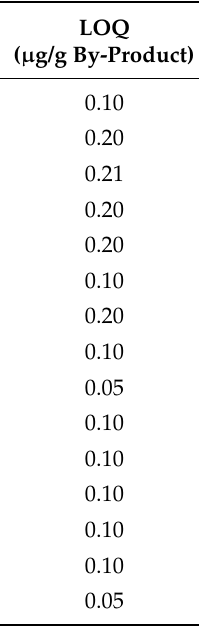
Table 4. Analytical parameters of detection maximum absorption wavelength ( λ max ), linearity, LOD, and LOQ employed to determine bioactive phenolic compounds studied. Phenolic